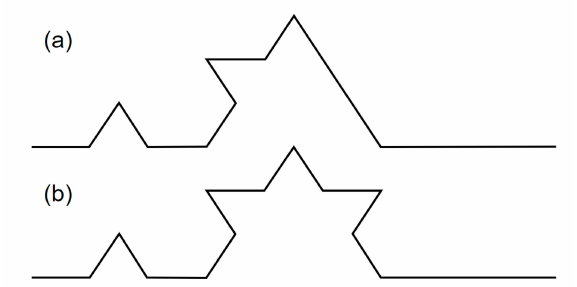
Figure 2. Two curves with the same ht-index. The first curve ( a ) is less similar to the Koch curve than is the second curve ( b